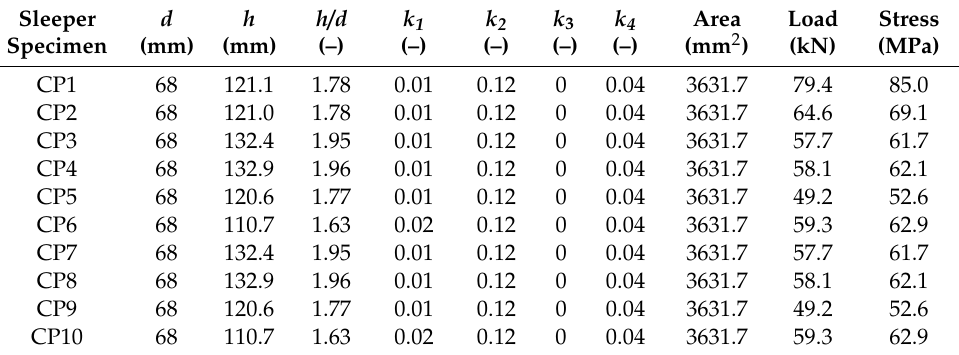
Table 1. Results of the concrete extraction and compression test.